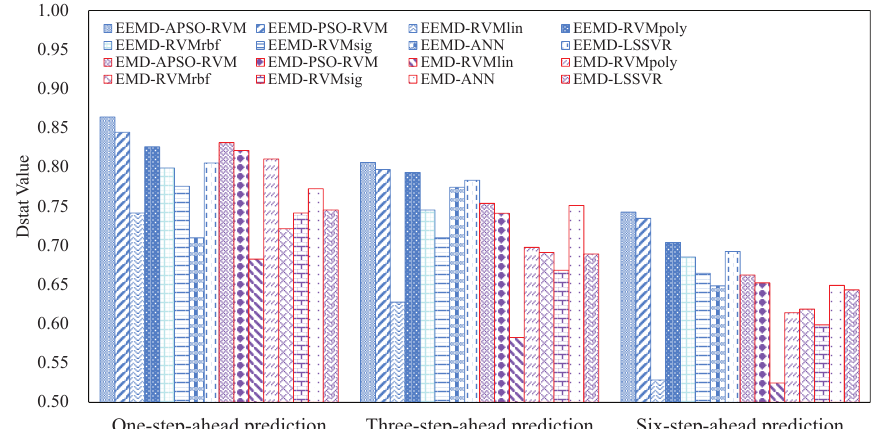
Figure 7. RMSE by different ensemble methods.